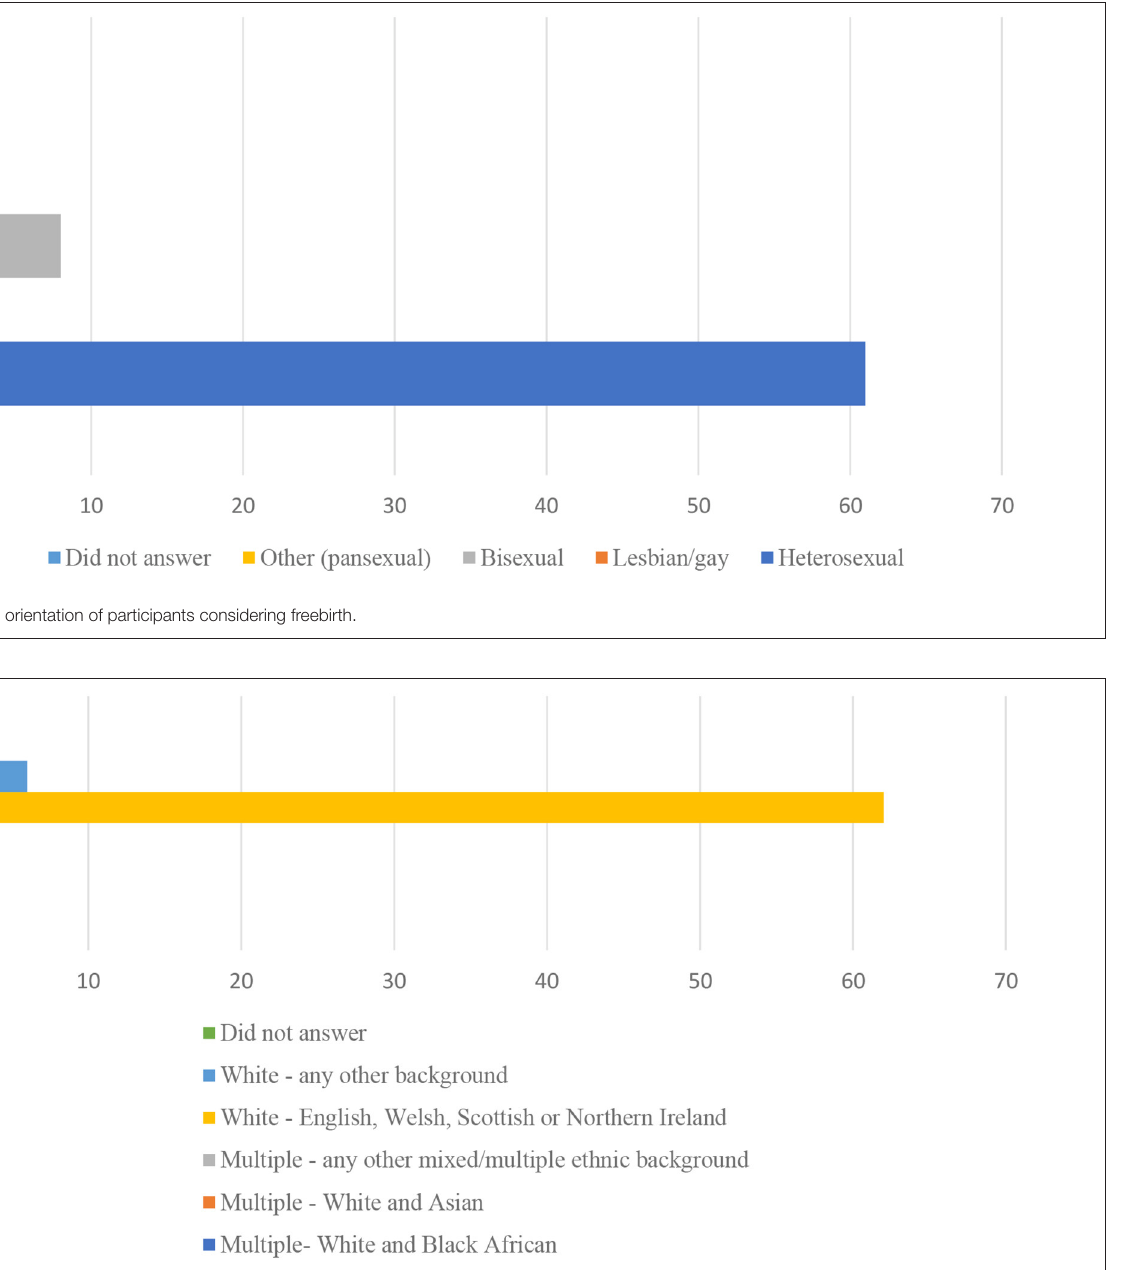
respondents considered, and the reasons that